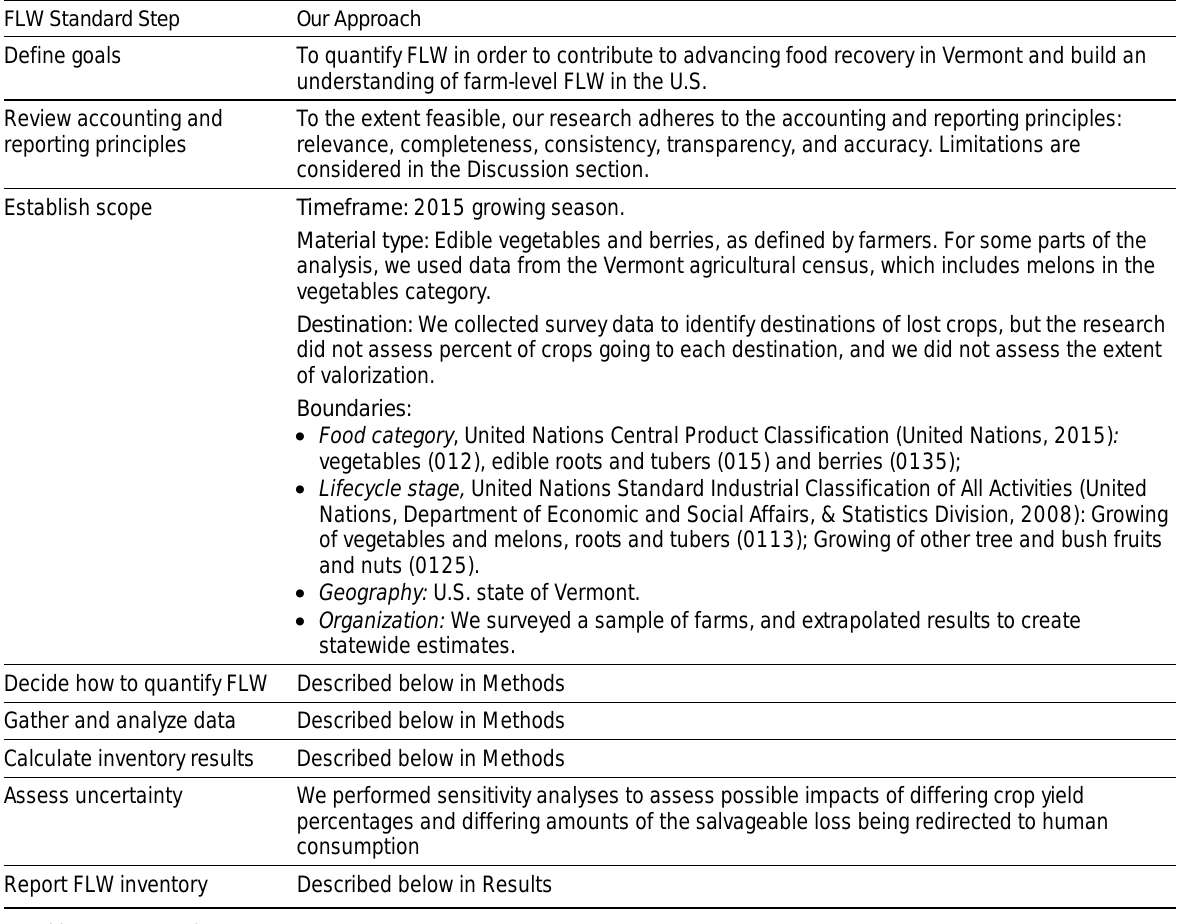
Table 1. Research Approach in Context of the Requirements in the Food Loss and Waste Standard